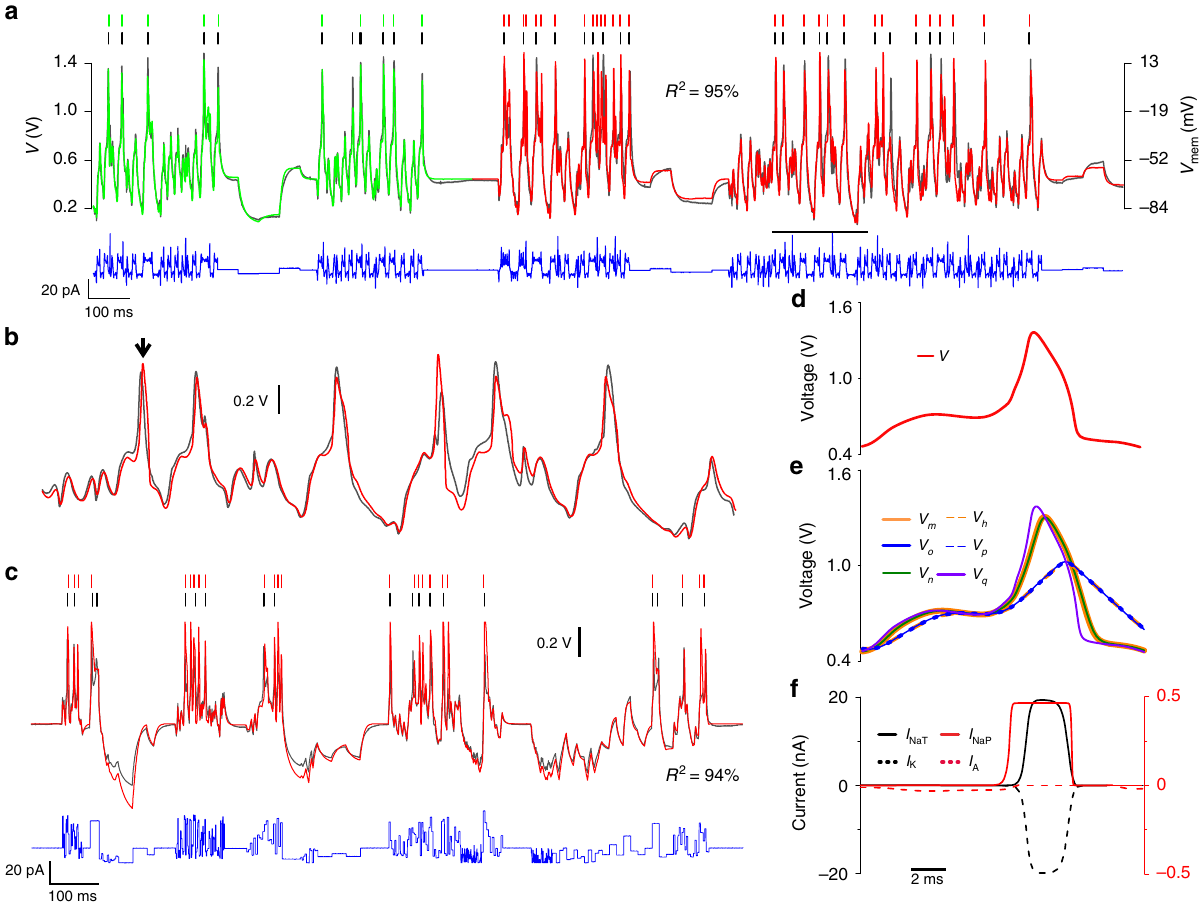
Fig. 5 Assimilation and prediction of a respiratory neuron. a Intracellular recording of a respiratory neuron acquired from a slice of the Bötzinger region of the rat brain stem (black line). The neuron was stimulated with a current waveform alternating hyperchaotic oscillations and current steps (blue line). The RN SSN model was used to assimilate the experimental membrane voltage over a 920-ms-long window (green trace) to estimate the optimum parameters. a – c The completed RN SSN model predicts the membrane voltage (red traces) in quantitative agreement with observations (black traces) for a very wide range of current waveforms. Detail of: d an action potential, e gate variables and f ion current